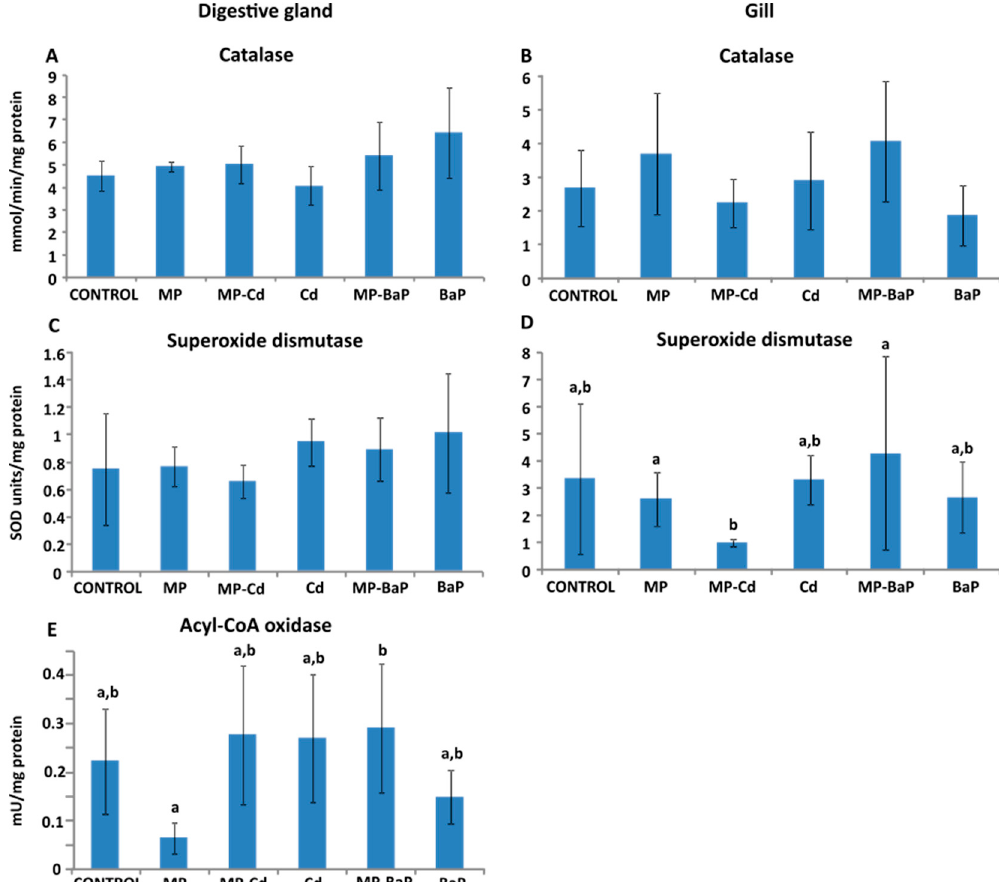
Figure 3. Activity of the antioxidant enzymes catalase in the digestive gland ( A ) and gills ( B ), superoxide dismutase in the digestive gland ( C ) and gills ( D ), and activity of acyl-CoA oxidase in the digestive gland ( E ) of mussels, presented as mean ± standard deviation ( n = 6). Different letters indicate statistically significant differences ( p < 0.05) according to the Tukey’s post hoc test after one-way ANOVA.